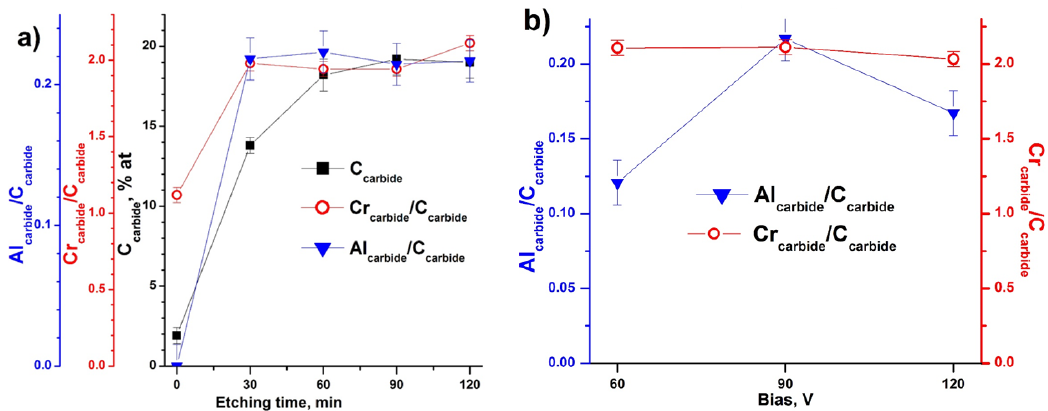
Figure 5. ( a ) Atomic concentration of carbide-like carbon in relation to all elements; atomic ratio of chromium carbide (574.3 eV) and aluminum carbide (72.5–72.8 eV) states to carbide like carbon (282.8 eV); and Ar + etching time obtained for Cr-Al-C at 90 V; ( b ) Cr carbide /C carbide and Al carbide /C carbide ratios obtained for all samples after 120 min of Ar + ion etching vs. bias voltage.